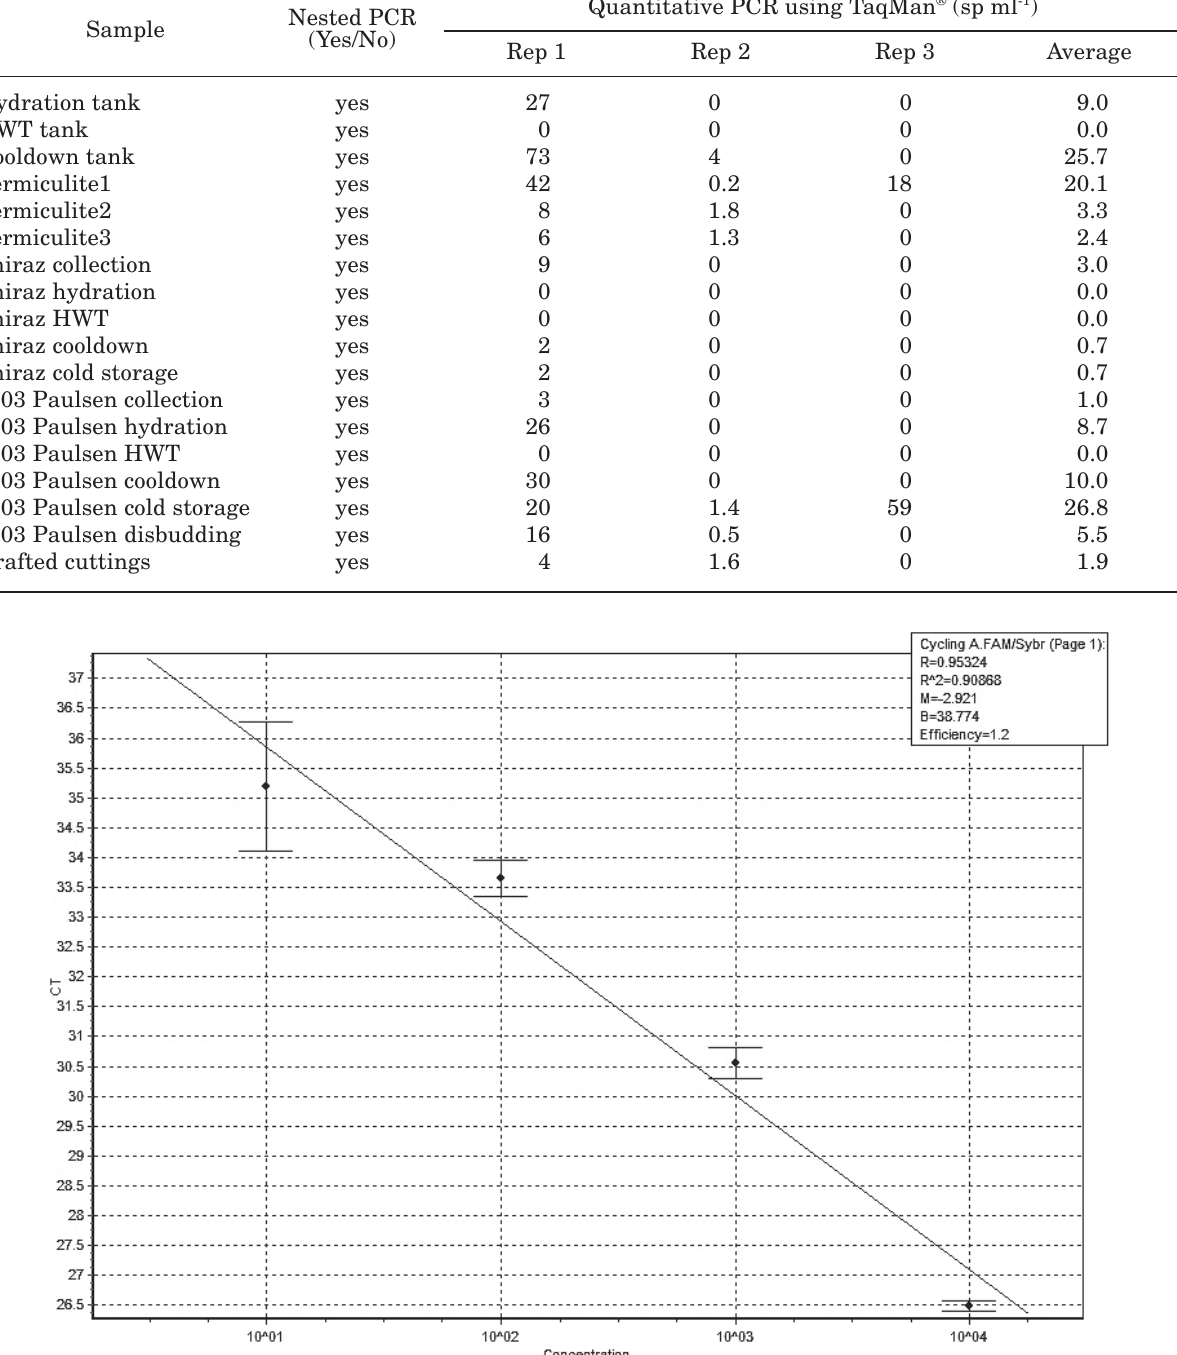
Table 3. Detection and quantification of P. chlamydospora in grapevine nursery wash water samples from 2003.